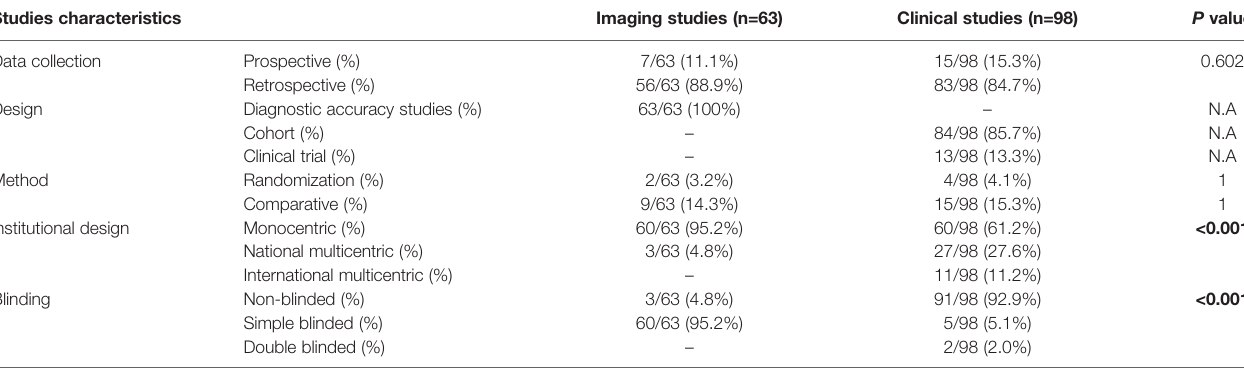
TABLE 2 | Study characteristics per subgroup.